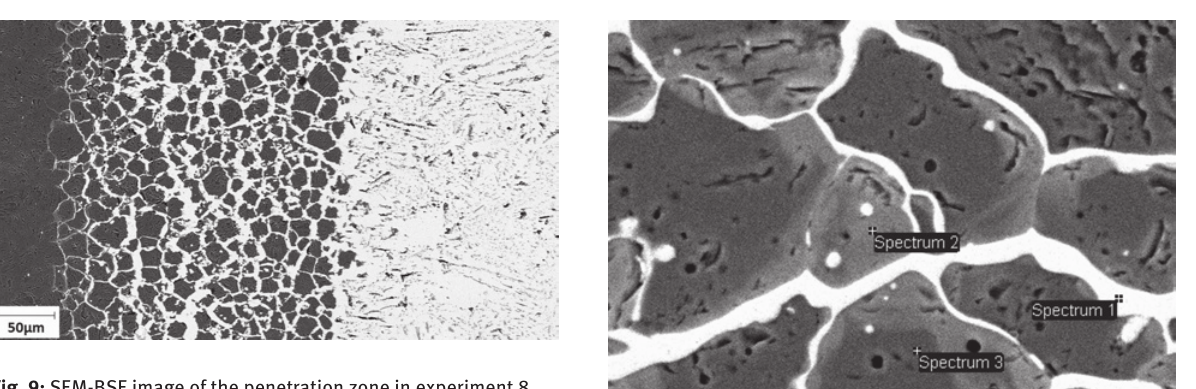
Fig. 9: SEM-BSE image of the penetration zone in experiment 8 (FeMo3.5-TiC B)